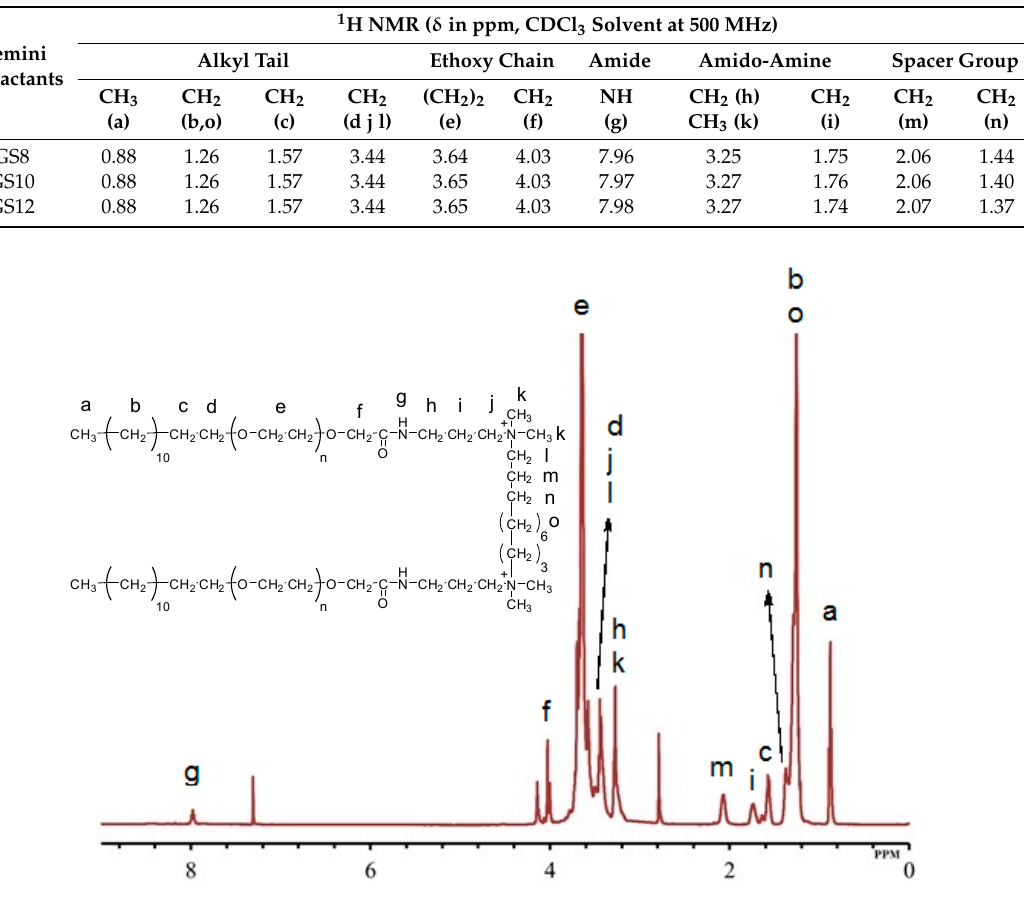
Figure 2. 1 H NMR of quaternary ammonium gemini surfactants (GS12). Table 1. 1 H NMR data exhibiting description of proton-type in GS12 [33–37].